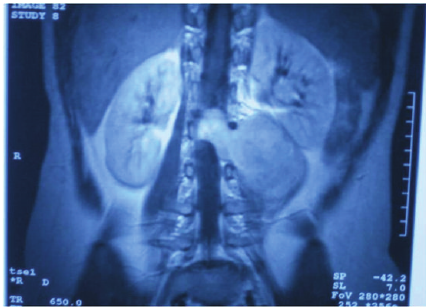
Figure 1: MRI revealed a huge mass adjacent to the first and second lumbar vertebrae with extension into the spinal canal.